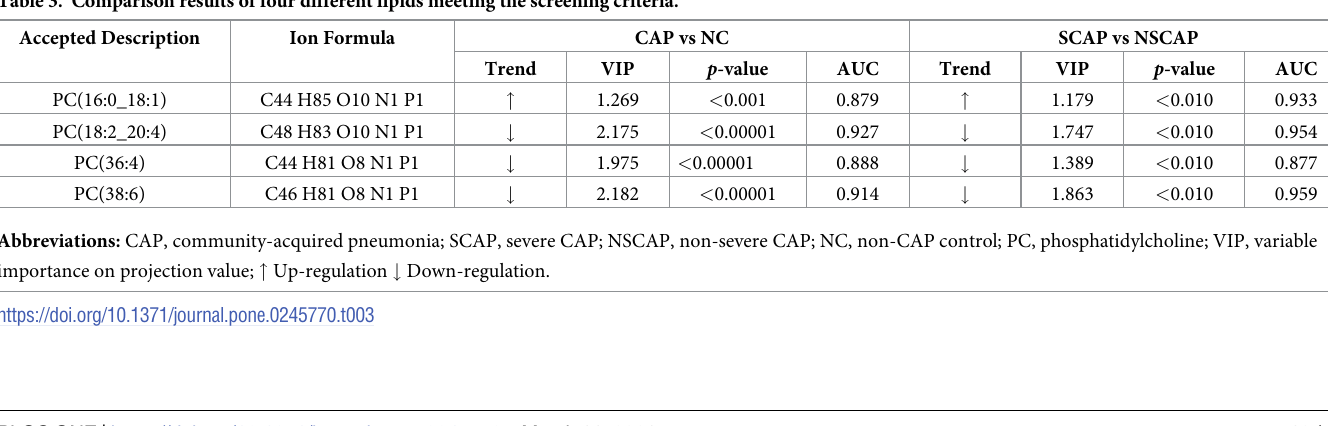
Fig 3. Flow chart of target differential lipid screening process. CAP, Community-acquired pneumonia; NC, Non-CAP controls; NSCAP, Non-severe CAP; SCAP, Severe CAP; VIP, variable importance on projection; ROC, Receiver operating characteristic; AUC, area under the curve.